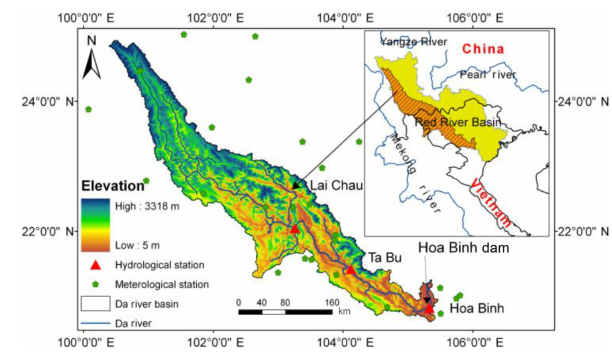
Figure 1. Location of DRB and the hydro-meteorological stations.